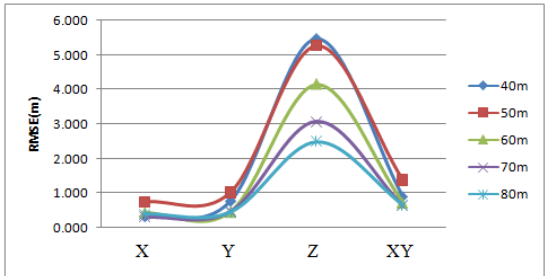
Figure 8. Graph of RMSE for Checkpoints (Different Altitude)